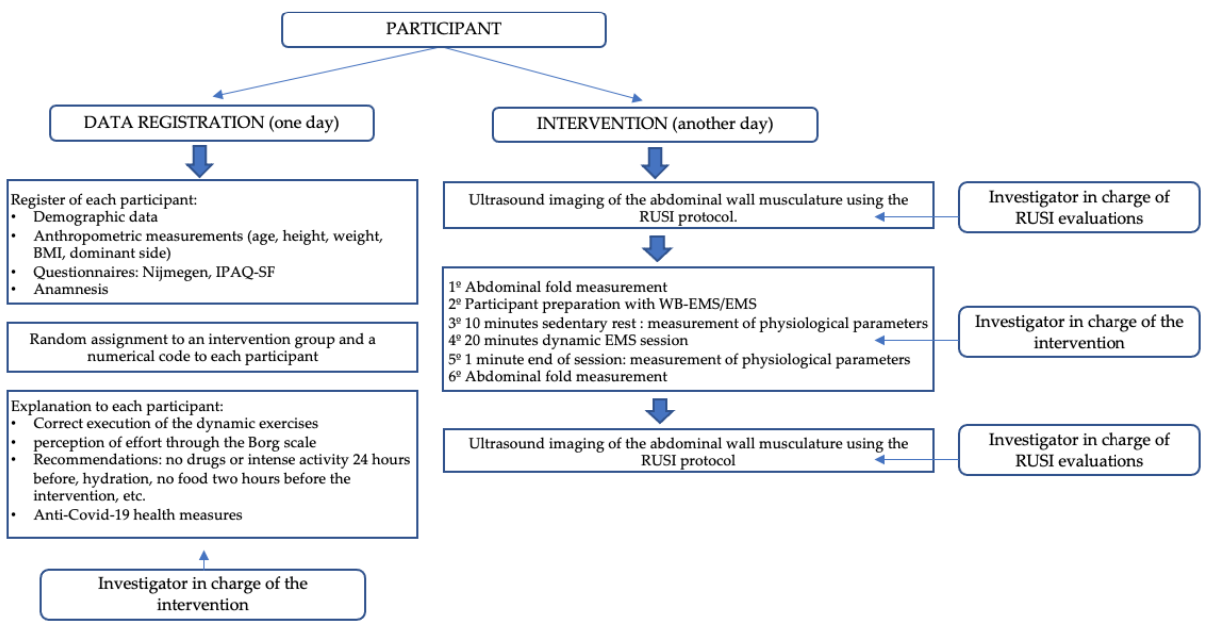
Figure 1. Diagram of the intervention procedure.